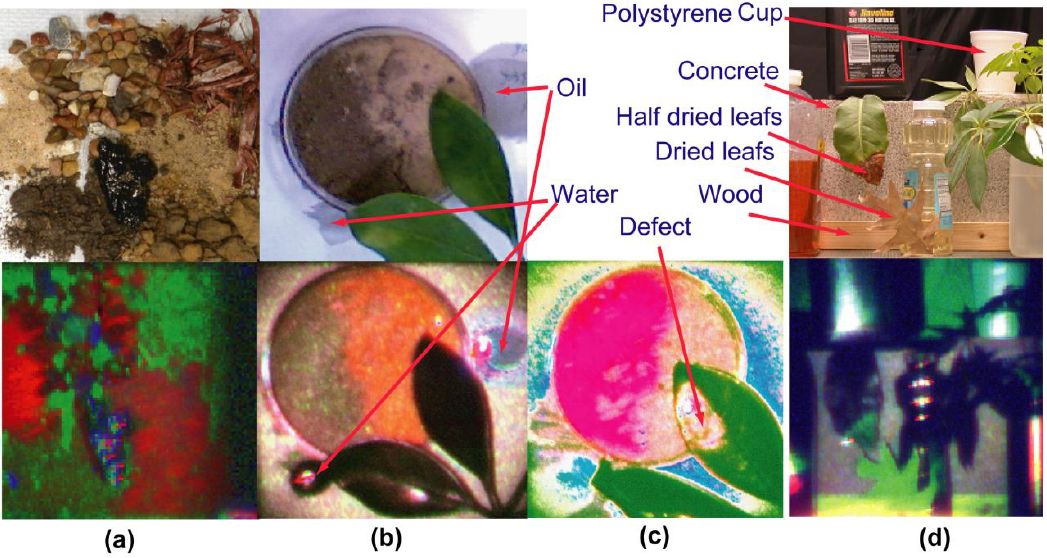
Figure 9. Top row: target photographs. Bottom row: corresponding FCI from M/LWIR multispectral images. (a) Mineral collection. The M/LWIR FCI shows sand (quartz) as red, humus soil and woods as brownish/dark green, and asphalts as bluish. The beam was ~2.5 cm, and larger than most pebbles. (b) Sandy soil, humus soil, and leaves. The M/LWIR FCI shows sandy and humus soils have different colors. (c) M/LWIR FCI of the same target in (b) under a slightly different arrangement. A barely discernible yellowish spot of a leave became very pronounced in the FCI. (d) Household objects. Dried leaves are distinctive from green leaves (black because of weak signals). A piece of wood appears as yellow; and concrete appears as gray. Other shiny objects with specular reflection caused the dynamic range problem as spectra of weak signals (dark region) were lost in signal digitization (flare